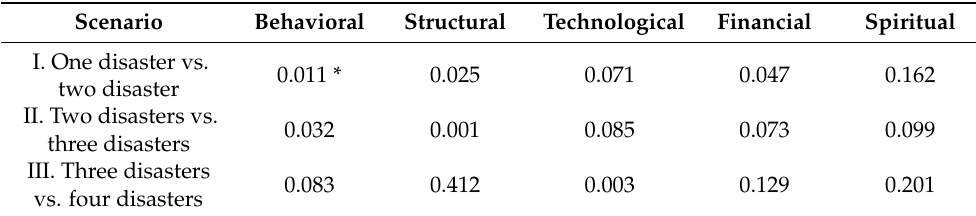
Table 4. Marginal and combined effects of disaster frequencies and coping strategy.